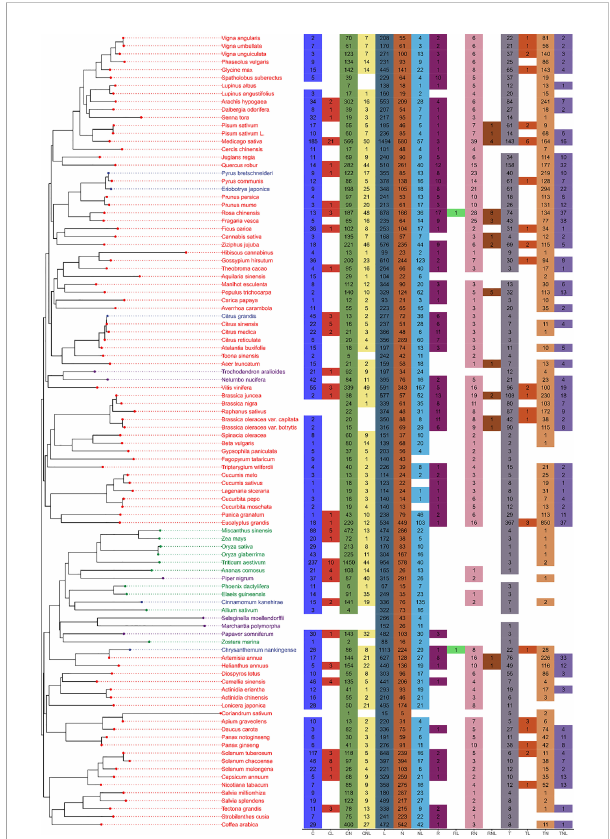
FIGURE 1 Survey of NLRs across 100 plant genomes. The left panel shows the phylogenetic tree created utilizing NLR domain sequences. Eudicots, monocots, and other plants are represented by green, red, and blue letters, respectively. The right panel shows the NRL gene groups. Numbers in each cell indicate the number of NLRs identi fi ed in each plant genome. Blank cells indicate that no NLRs were discovered in the plant